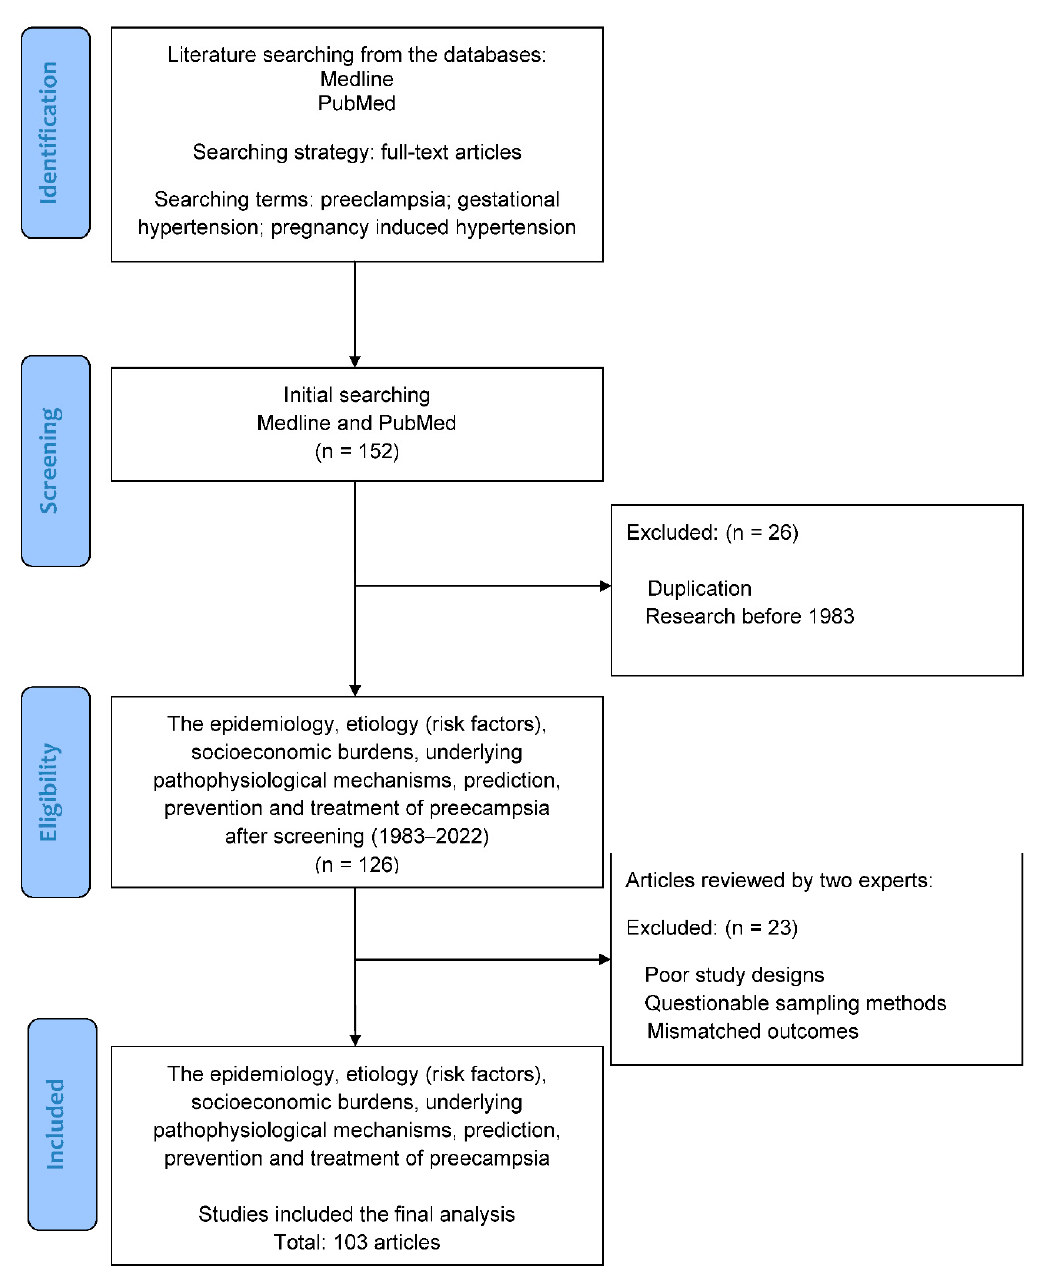
Figure 2. Flowchart of database searching, screening, and inclusion of the references selected from the literature.